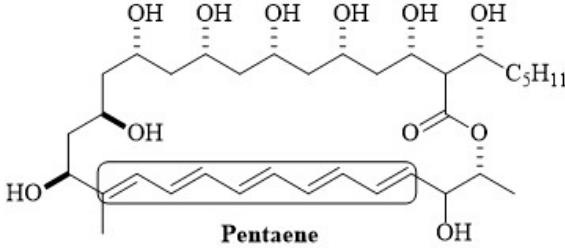
Figure 4. Structure of Filipin III 3 .